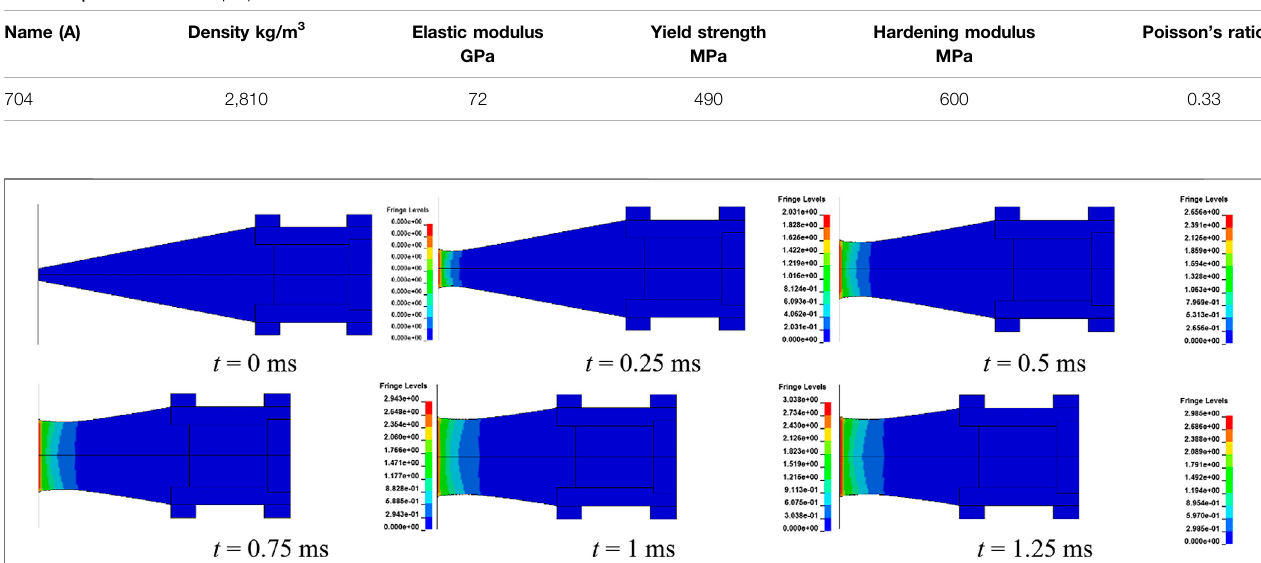
Figure 2 . The shell and tail cover material (7A04 aluminum alloy) is described